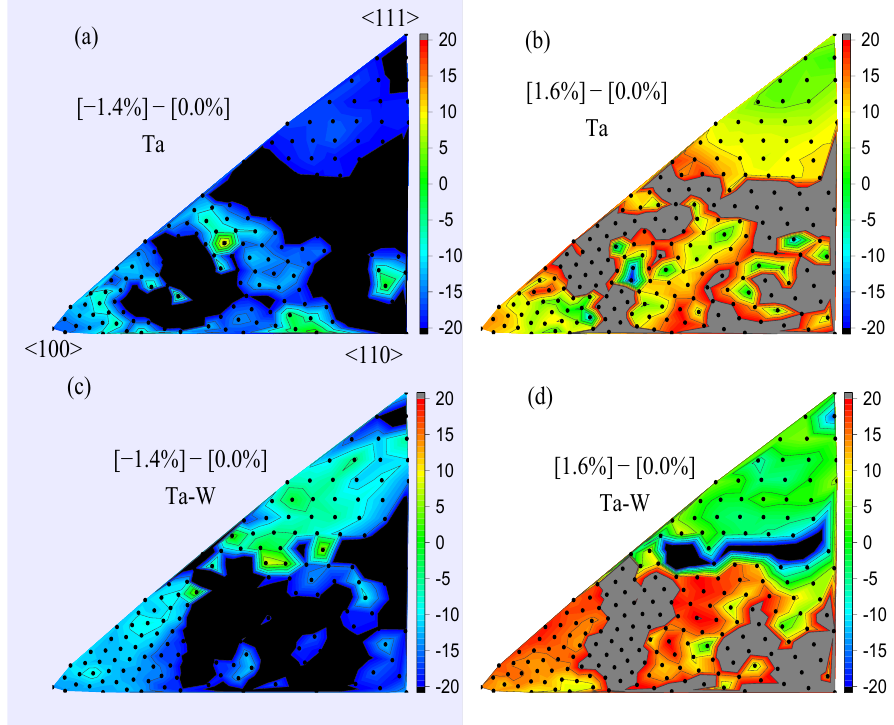
8 of 13 Figure 6 . Change rate of the deformed TDE for specific directions in Ta: (d 1 ) [1 1 1], (d 2 ) [1 1 0], (d 3 ) [1 0 0], (d 4 ) [3 2 1], (d 5 ) [1.12 3.8 − 0.5], (d 6 ) [−0.441 −0.086 −0.894]. Each point represents the average of 20 simulations of different vibrational timings. To further analyze the direction dependence of E CR , the results over 210 directions are shown in Figure 7. The ECRs are calculated for hydrostatic deformations in Ta, and for Ta – W, the results for the 1.4 % compression strain in (Figure 7a,c) and for the 1.6%